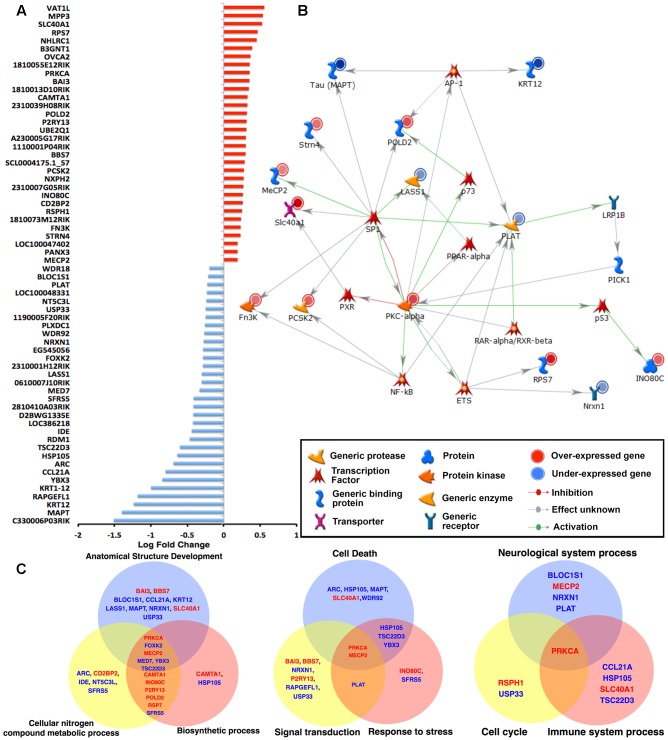
Microarray analysis of the hippocampi of 6-month-old WT and hTauMaptKO(Duke) mice.
(A) Total RNA from hippocampi of 6-month-old WT and hTauMaptKO(Duke) mice was hybridized to MouseWG-6 v2.0 Expression BeadChip (Illumina®). Expression of 64 genes that were significantly altered in hTauMaptKO(Duke) mice compared to WT is shown. Values displayed as fold change in expression level: up-regulated (red) and down-regulated (blue) genes. Data represents mean fold change from three mice per genotype. (B) Gene interaction network analysis (using Metacore analytical suite) for the 64 significantly altered genes in hTauMaptKO(Duke) mice compared to WT mice. The genes with red (or blue) next to their graphic key is either up- (or down-) regulated. As expected, endogenous mouse tau (MAPT) is one of the most down-regulated genes. Other genes relevant to neuronal function or neurological disease include Prkca, Mecp2, Strn4, Slc40a1, Pold2, Pcsk2 (up-regulated) and Krt12, Lass1, Plat and Nrxn1 (down-regulated). Many of the altered genes are regulated by the transcription factor SP1. (C) Venn diagrams showing GO’s biological processes when all 64 genes are categorized for top biological processes segregate into three distinct Venn diagrams: Group 1: anatomical structure development – 17 altered genes out of total 47, i.e., 17/47; cellular nitrogen compound metabolic process – 15/47; biosynthetic process 13/47. Group 2: cell death – 9/47; signal transduction 8/47; response to stress 8/47. Group 3: neurological system 5/47, cell cycle 2/47 and immune system processes 4/47. Note the genes written in red (or blue) are significantly up- (or down-) regulated.